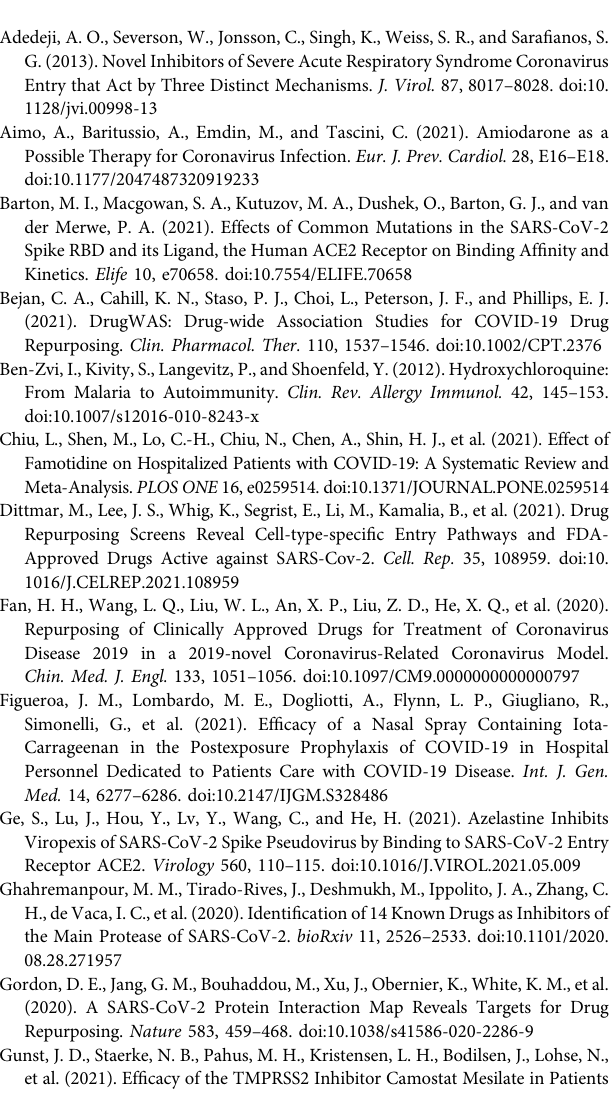
Supplementary Figure S1 | Schematic outline of drug prediction approach. (A) Illustration of the fi rst step: Shannon entropy approach for the description of small molecules. The 2D molecular structure is converted into a topological graph (network) in which every atom (node) is attributed with an atom type (feature). Theshortestpathlengthiscalculatedforeachandeveryatompair(featurepair).The shortest path length distribution N(q) of a given feature pair (i) is converted into a probability p(q) from which the Shannon entropy S i is calculated. The Shannon entropy descriptor SHED of a molecule is therefore the Shannon entropy vector S vectorcomprisingentropyvaluesfortheindividualfeaturepairs. (B) Illustrationofthe second step: SHED-based prediction of pathway pro fi les. The Shannon entropy vector of a molecule is used to screen the DrugBank database for SHED analogs. prevalent/relevant pathways are indicated in red). Supplementary Figure S2 | Azelastine is effective in reducing SARS-CoV-2 viral genome counts in vitro . Vero E6 (A) or Vero-TMPRSS2/ACE2 cells (B – E) were infected with variants of SARS-CoV-2 simultaneously with or 30 min prior to the addition of 0.4 to 12.5 µM of azelastine. After 48 h, RNA was extracted from the cell